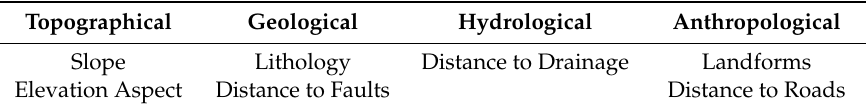
Table 1. Conditioning factors classified based on the main four